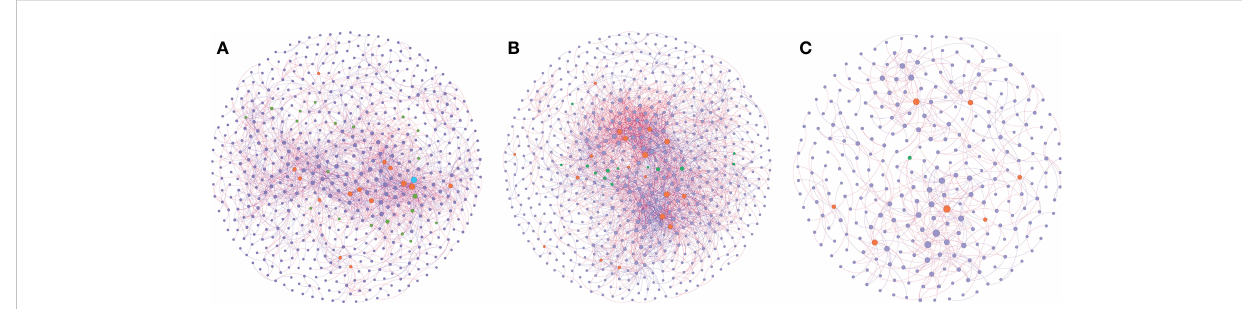
FIGURE 5 Co-occurrence network inference of the rhizosphere microbiomes compared. Co-occurrence index based on SprCC method correlation of 16S rRNA genes (ASV level) were extracted from soil samples in three conditions: healthy soil (A) , disease soil (B) and the soil supplemented with biocontrol agent (C) . Correlation was calculated using iNAP online pipeline “ SprCC ” , with correlation strength exclusion threshold = 0.1, 100 shuf fl ed times, threshold value > 0.9 and p value = 0.05. Each node represented a single ASV and hub nodes were labeled differed with other nodes (module hubs labeled in orange, connectors labeled in green, network hubs labeled in blue and other nodes labeled in purple). A red edge indicated a positive correlation between two individual nodes, while a blue edge indicates a negative correlation.